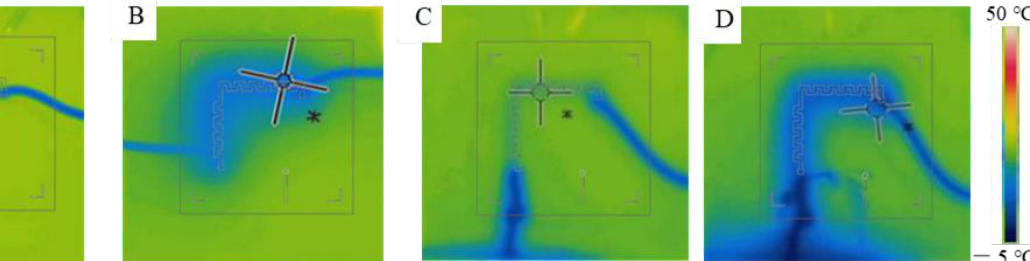
Figure 8. Cooling tests below room temperature recorded by thermal imager. ( A ) Beginning of slow cooling with CaCl 2 ; ( B ) steady stage of slow cooling with CaCl 2 ; ( C ) beginning of fast cooling with CaCl 2 ; ( D ) steady stage of fast cooling with CaCl 2 .